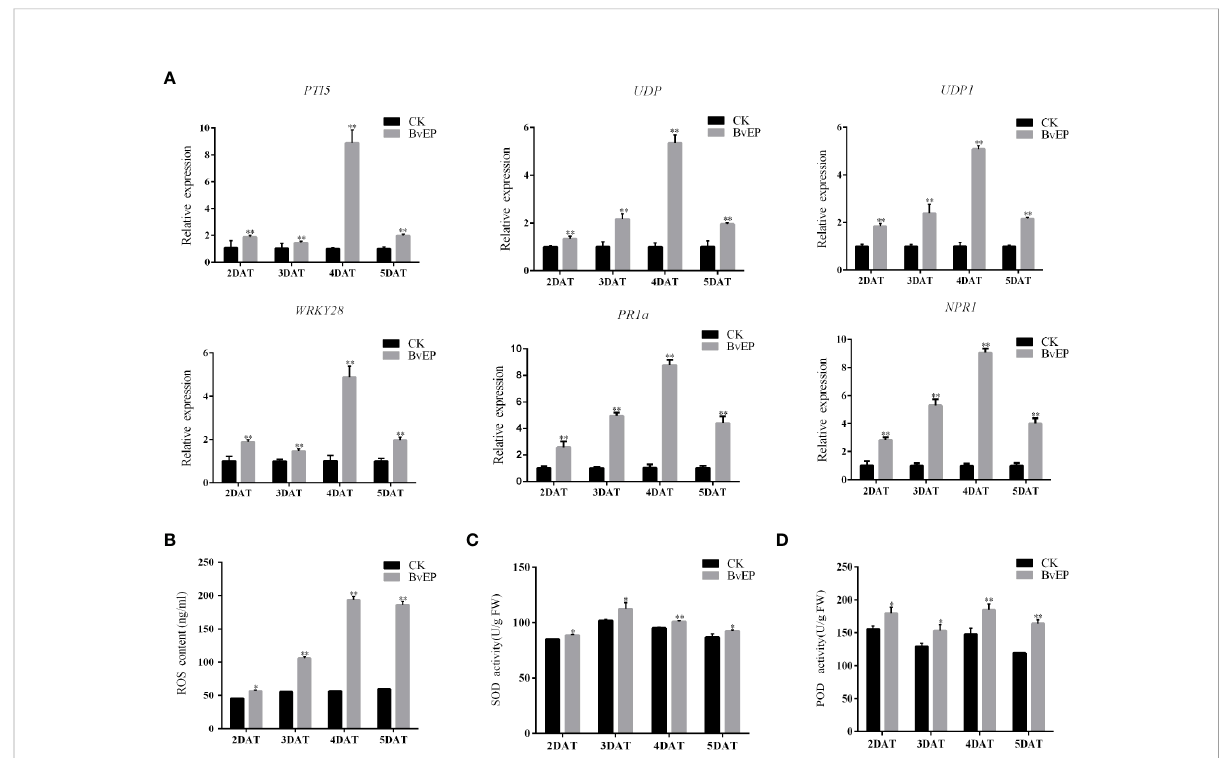
FIGURE 6 Effects of BvEP on resistance-related genes, ROS content and related enzyme activities in tomato fruits during storage. (A) Expression levels of marker genes of resistance pathways in tomato fruit after transient transformation with pK7LIC4.0 and pK7LIC4.0-BvEP; (B) ROS content in tomato fruit at 2 DAT, 3 DAT, 4 DAT, and 5 DAT with pK7LIC4.0 and pK7LIC4.0-BvEP; (C, D) are separately SOD and POD enzyme activities in tomato fruit at 2 DAT, 3 DAT, 4 DAT, and 5 DAT with pK7LIC4.0 and pK7LIC4.0-BvEP; asterisks indicate statistically signi fi cant differences (* p < 0.05, ** p <